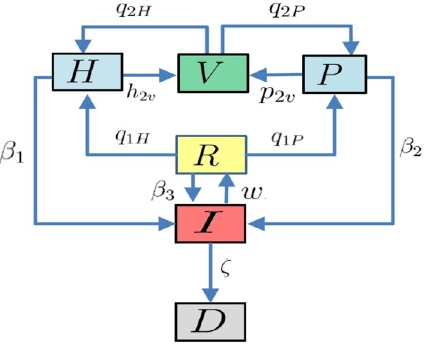
Figure 1. Schematic diagram outlining the infection kinetic profile of our model PHIRVD: healthy susceptible ( H ); predisposed comorbid susceptible ( P ); infected ( I ); recovered ( R ); herd immunized ( V ) and dead ( D